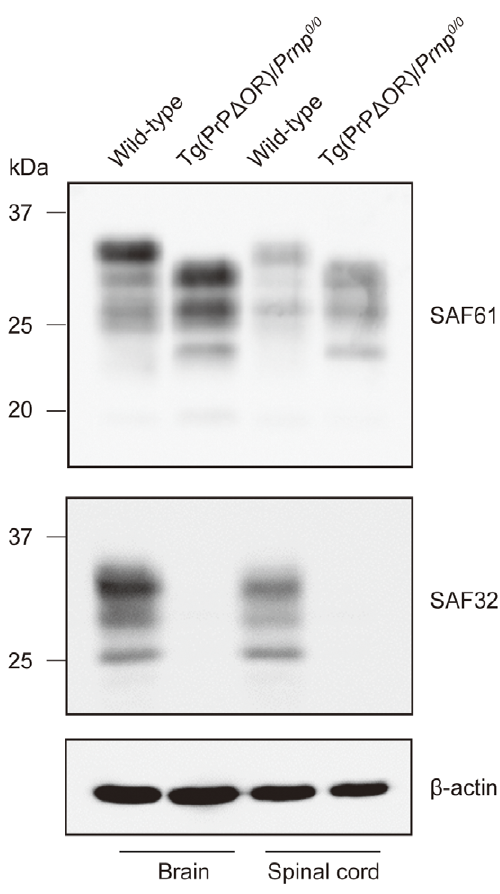
Figure 1. Overexpression of PrP D OR in the brains and spinal cords of tg(PrP D OR)/ Prnp 0/0 mice. The brain and spinal cord homogenates from tg(PrP D OR)/ Prnp 0/0 mice and wild-type mice were subjected to Western blotting with SAF61 or SAF32 anti-PrP antibodies. The expression of b -actin was detected in these homogenates as an internal control.